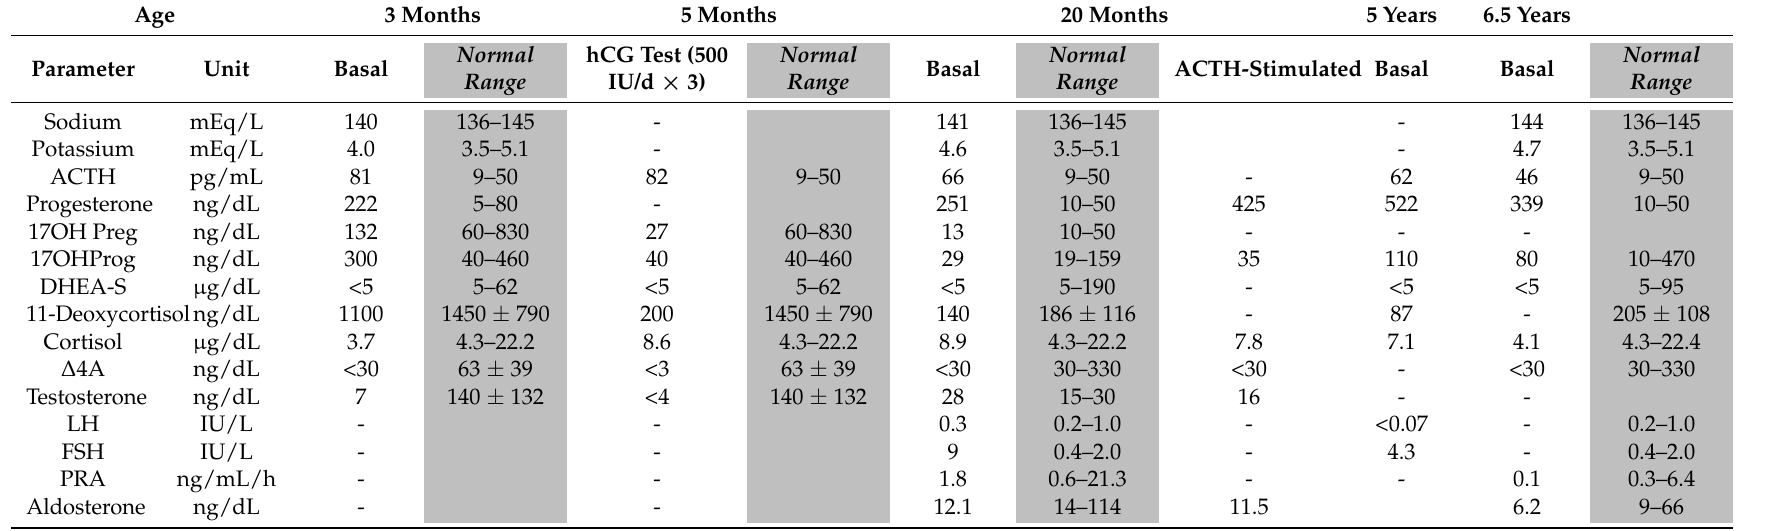
Table 2. Laboratory findings in our patient harboring compound heterozygote CYP17A1